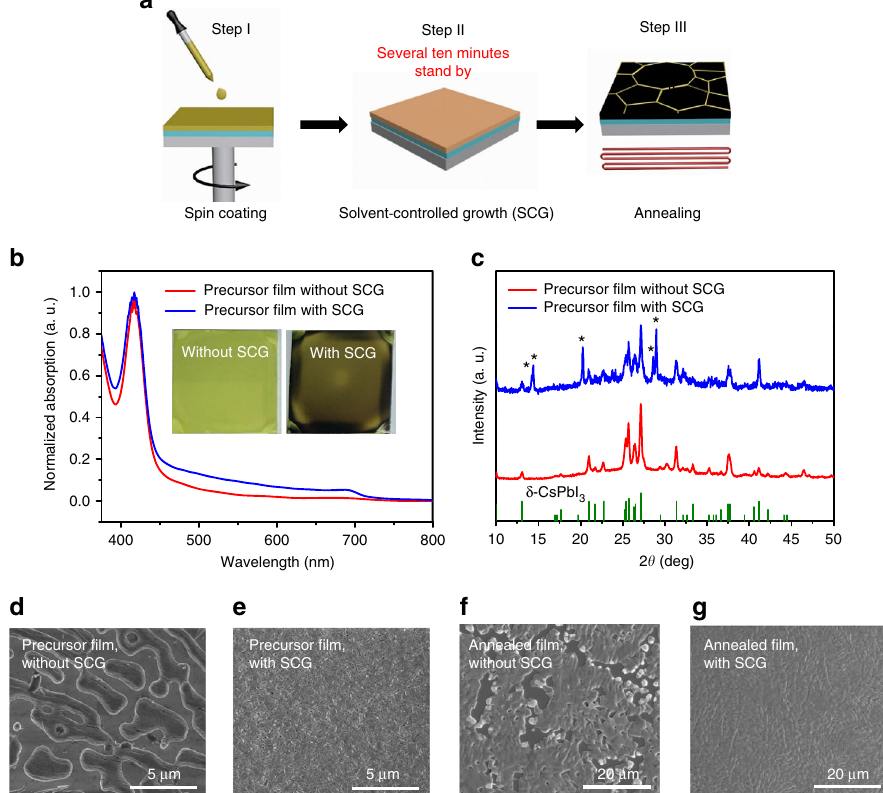
Fig. 1 Solvent-controlled growth (SCG) for CsPbI 3 deposition. a Schematic illustration of CsPbI 3 -perovskite crystallization procedures via solvent-controlled growth (SCG). b Normalized absorption of CsPbI 3 -precursor fi lms with and without SCG, inset shows the precursor fi lm images without and with SCG. c X-ray diffraction (XRD) pattern of CsPbI 3 -precursor fi lms without and with solvent-controlled growth (SCG). Without SCG, the diffraction peaks are mainly from the δ -phase CsPbI 3 , while after SCG, part of δ - phase CsPbI 3 was transferred into β -phase CsPbI 3 (a slight distorted α -phase CsPbI 3 ). The diffraction peaks labeled as “ * ” are the diffraction peaks from the β -phase CsPbI 3 . d , e Scanning electron microscopy (SEM) image of CsPbI 3 perovskite precursor fi lm without and with SCG, respectively, scale bar: 5 μ m. f , g SEM images of annealed CsPbI 3 perovskite precursor fi lms without and with SCG, respectively, scale bar: 20 μ